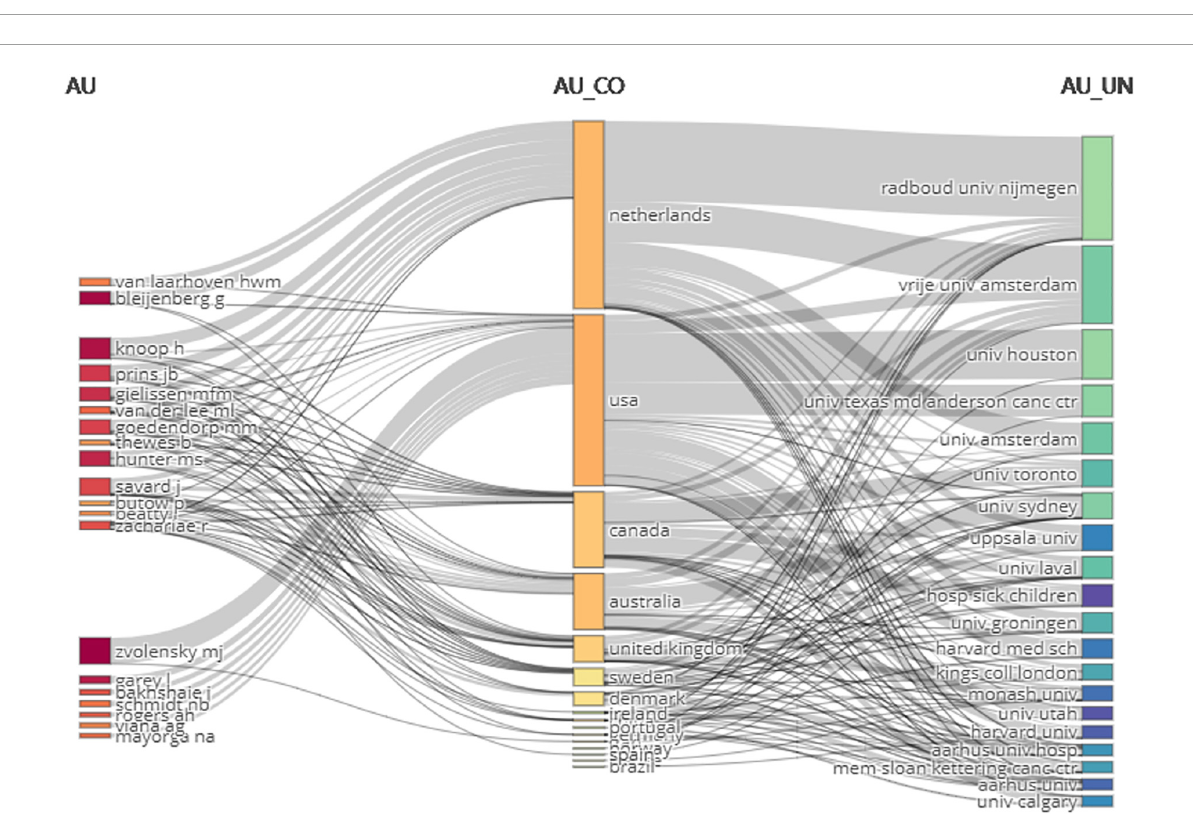
FIGURE9 The three-field diagram of the collaboration between different countries (middle) , authors (left) and organizations (right) (Occupied area represents the number of articles issued and the density of line indicates the closeness of cooperation).